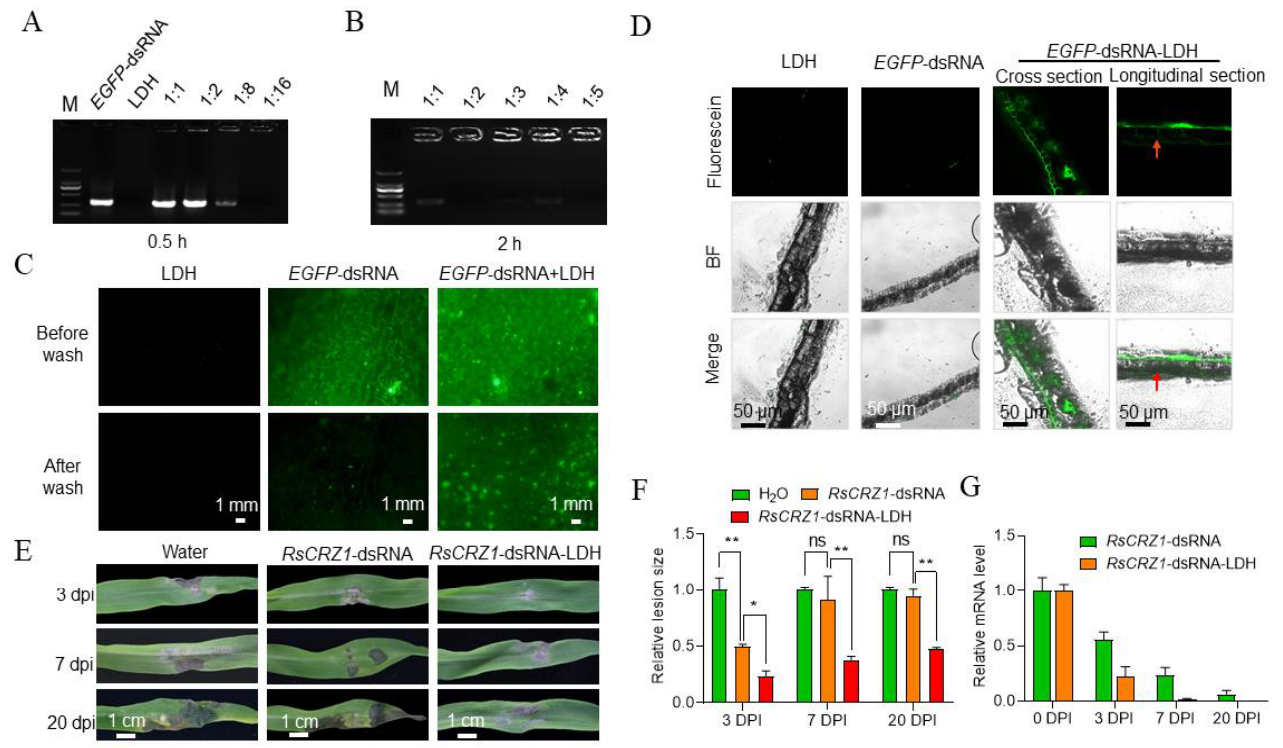
Figure 5. DsRNA loading capacity of LDH and protective effects of Rs CRZ1-dsRNA-LDH on plants. ( A ) Electrophoretogram of the mixtures of dsRNA and LDH at different ratios. dsRNA and LDH were mixed at 1:1, 1:2, 1:8, and 1:16 ratios for half an hour. ( B ) Electrophoretogram of the mixtures of dsRNA and LDH at different ratios. dsRNA and LDH were mixed at 1:1, 1:2, 1:3, 1:4, and 1:5 ratios for two hours. ( C ) Effects of LDH on the entry of dsRNA into tobacco leaves. Fluorescent signals were observed under confocal microscopy on tobacco leaves 24 h post-dsRNA treatment and before or after washing. ( D ) Effects of LDH on dsRNA entry into maize leaves and transport inside leaves. Twenty-four hours after EGFP -dsRNA-LDH was sprayed on maize leaves, cross and longitudinal sections were observed for fluorescence in the cells and intercellular space. ( E ) Effects of RsCRZ1 -dsRNA-LDH spray on R. solani -caused lesions on maize leaves. Plants were inoculated with the mycelial blocks of R. solani 24 h post- Rs CRZ1-dsRNA-LDH treatment. ( F ) Relative lesion sizes on maize leaves caused by R. solani at different times after Rs CRZ1-dsRNA-LDH spraying. ( G ) RT-qPCR detection of RsCRZ1 mRNA in R. solani in infected maize leaves at different time points after treatment with Rs CRZ1-dsRNA or Rs CRZ1-dsRNA-LDH. Mycelial blocks of R. solani were inoculated 24 h after Rs CRZ1-dsRNA and Rs CRZ1-dsRNA-LDH were sprayed on the leaves. ns, no significant differences; *, p < 0.05; **, p <